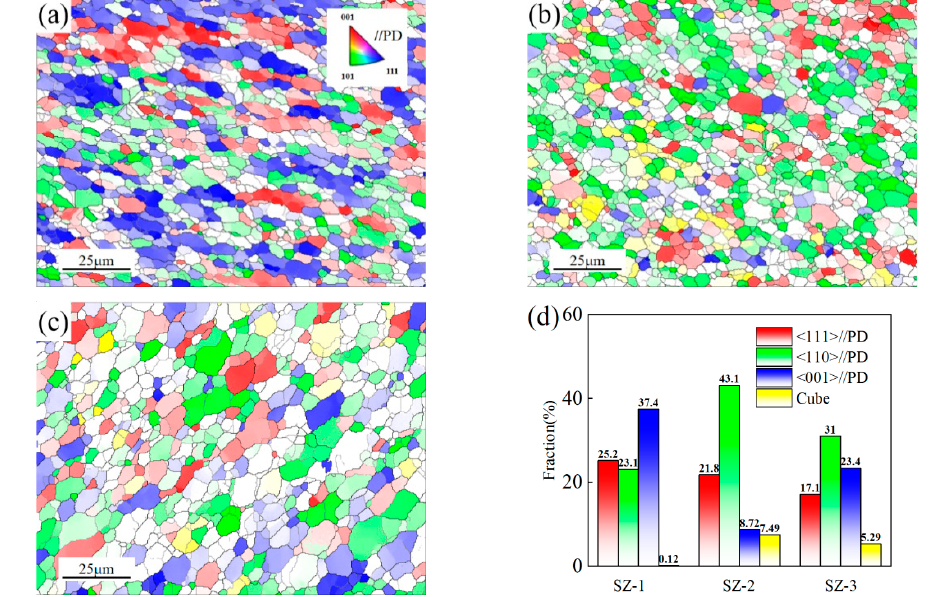
Figure 7. Texture contents of ( a ) SZ-1; ( b ) SZ-2; ( c ) SZ-3 and ( d ) texture statistics under various conditions.